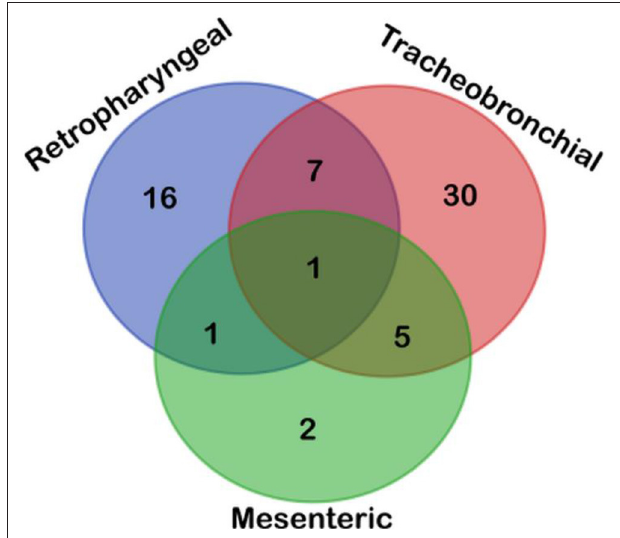
FIGURE 2 | Venn diagram depicted the topographical distribution of positive lymph nodes ( n = 77) according to their results obtained upon analyzing samples by microbiological culture, qPCR-IS 6110 , and Sanger sequencing. Most positive cattle were disclosed in tracheobronchial lymph node, followed by retropharyngeal and mesenteric lymph nodes, with most positive animals presenting only one positive lymph node highlighting the choice of tissue is a cornerstone for performing an accurate direct diagnosis of MTC.